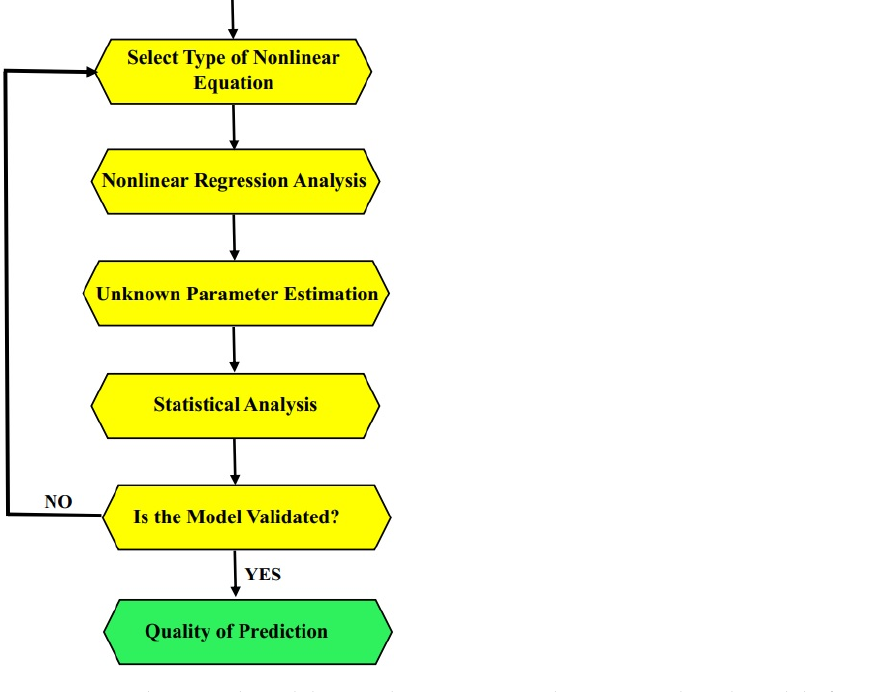
Figure 4. Mathematical modeling and regression analysis 4 Developed models for SMA-active con- fined concrete cylindrical